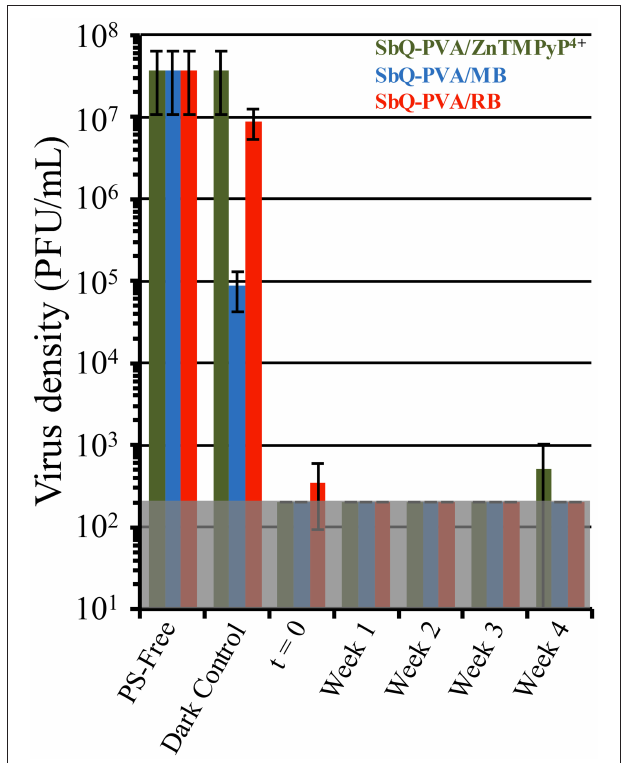
FIGURE 9 | Antiviral photodynamic inactivation studies of Vescom materials coated with SbQ-PVA/ZnTMPyP 4 + (green), SbQ-PVA/MB (blue) and SbQ-PVA/RB (red) against human coronavirus 229E (HCoV-229E). Samples were exposed to ambient room light conditions as indicated in the figure, followed by evaluation for antiviral efficacy. Results shown are for samples that had been repeatedly subjected to the aPDI assay a total of three times. Illumination conditions were the same as those listed in Figure 6